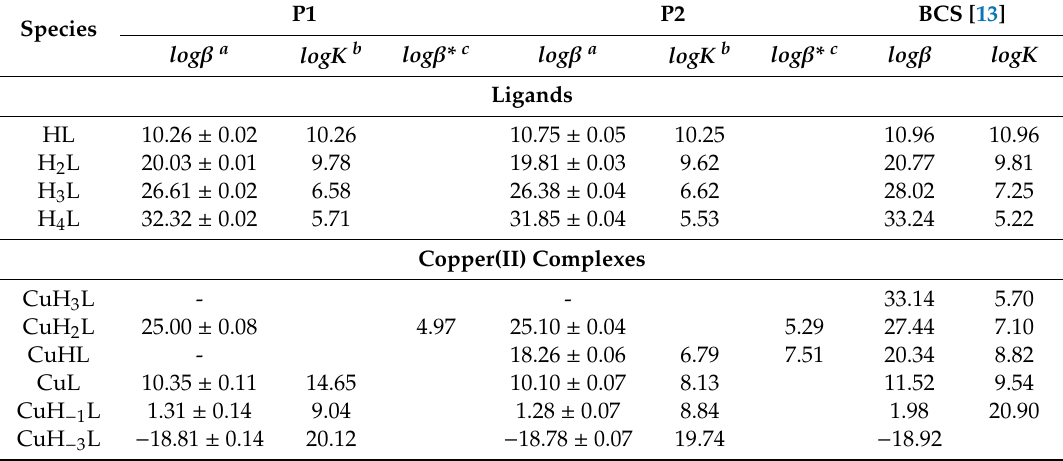
Table 1. Potentiometric data for Cu(II) / P1, Cu(II) / P2 and Cu(II) / BCS systems. P1 and P2 concentrations were 7 × 10 4 mol / L and pH-metric titration was performed in a 0.3 mol / L KCl solution using sample volumes of 1.5 mL. Measurements were carried out in a 2.5–10 pH range, at 25 ◦ C. The ligands to